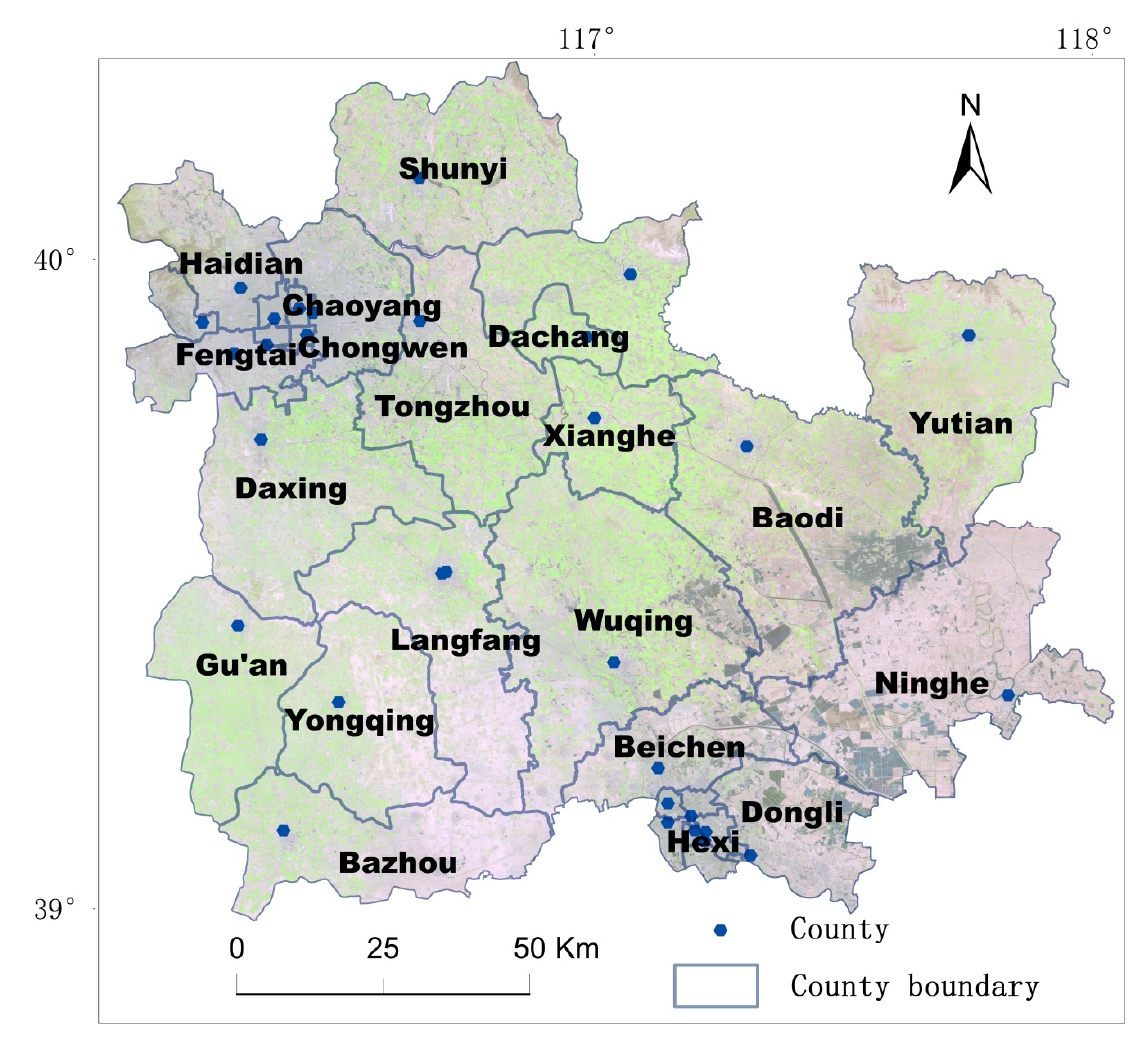
Figure 1. Location of the study area. Table 1. Parameter of SRTM DSM and AW3D30